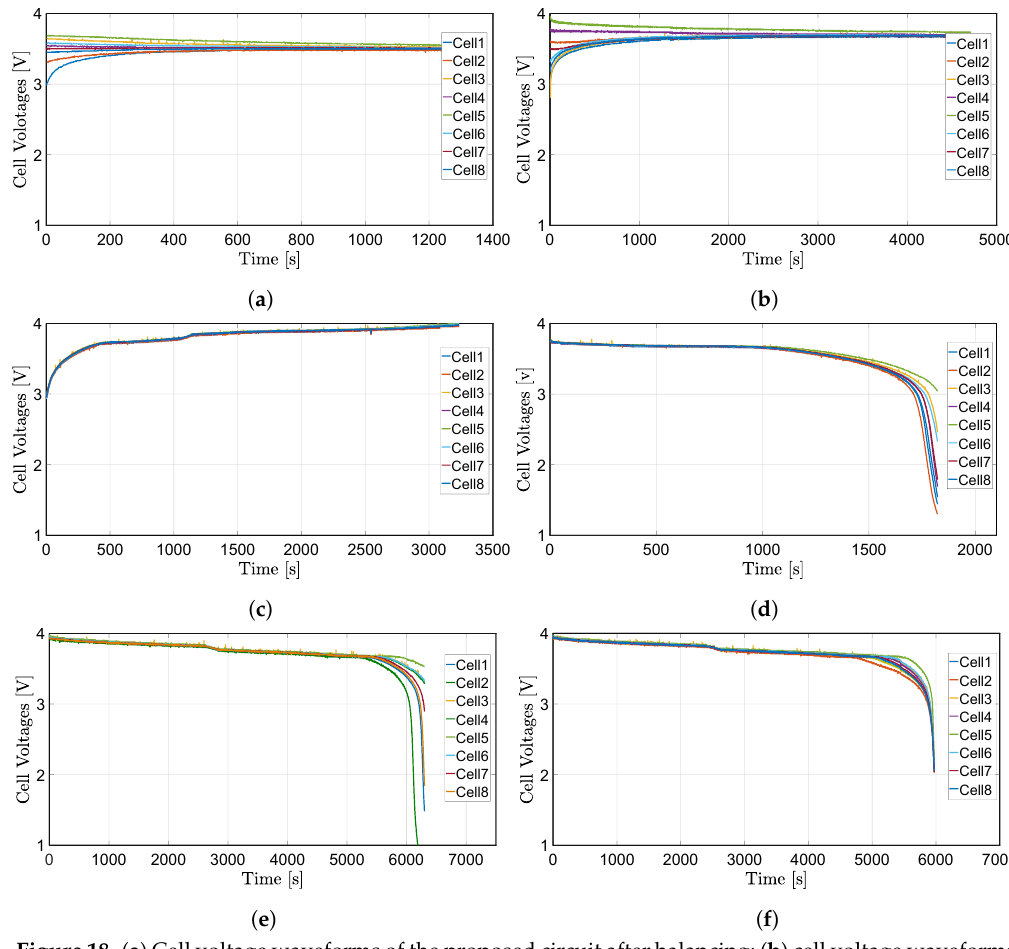
Figure 18. ( a ) Cell voltage waveforms of the proposed circuit after balancing; ( b ) cell voltage waveforms of the proposed circuit after balancing with one cell fully charged; ( c ) charging and equalizing voltage waveforms of the cells with balancing circuit; ( d ) the discharging voltage waveforms of the cells with nominal voltages without balancing circuit; ( e ) the discharging waveforms of the cells with fully charged cells without balancing circuit; and ( f ) the discharging waveforms of the cells with existing of the balancing